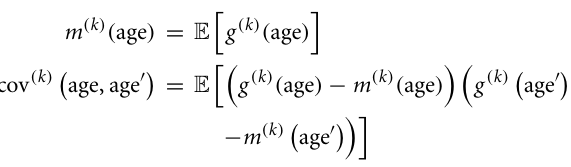
FIGURE 3 |Application of a non-parametric age model in a large cross-sectional healthy subjects sample of voxel-based morphometry data ( n = 1094, 18–94years, normalized gray matter volume segment). The voxel-wise age trajectories were achieved using a smoothing spline regression technique with generalized cross-validation to identify the optimal smoothing